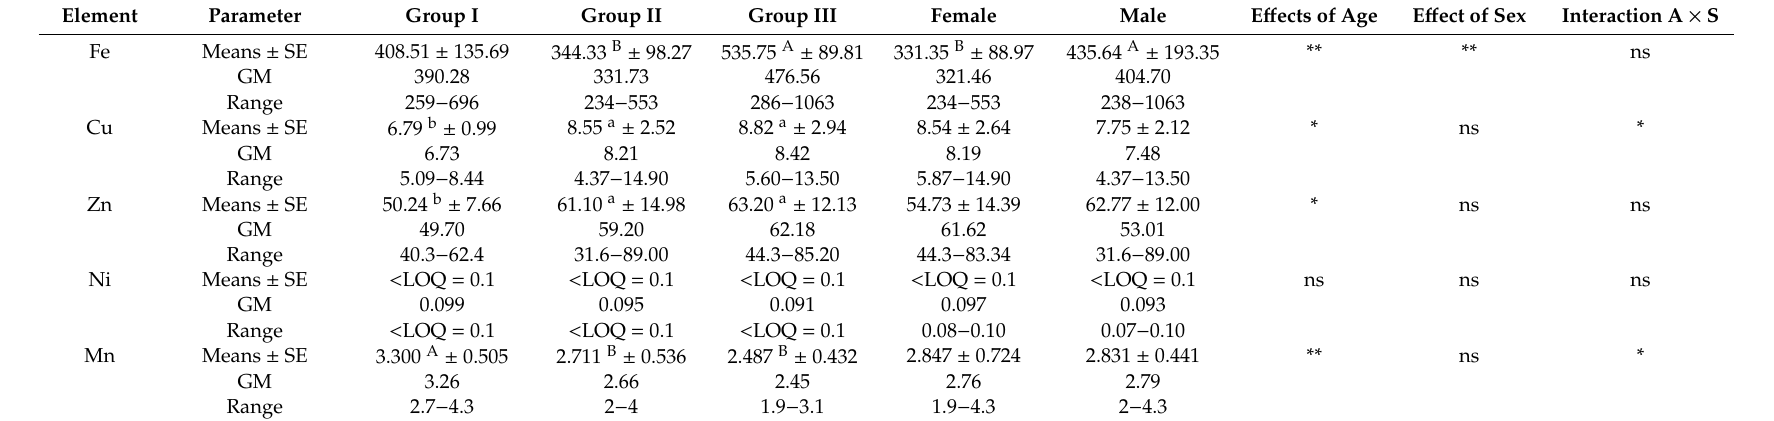
Table 4. Concentration of microelements in wild boar liver (mg · kg − 1 w.w.).